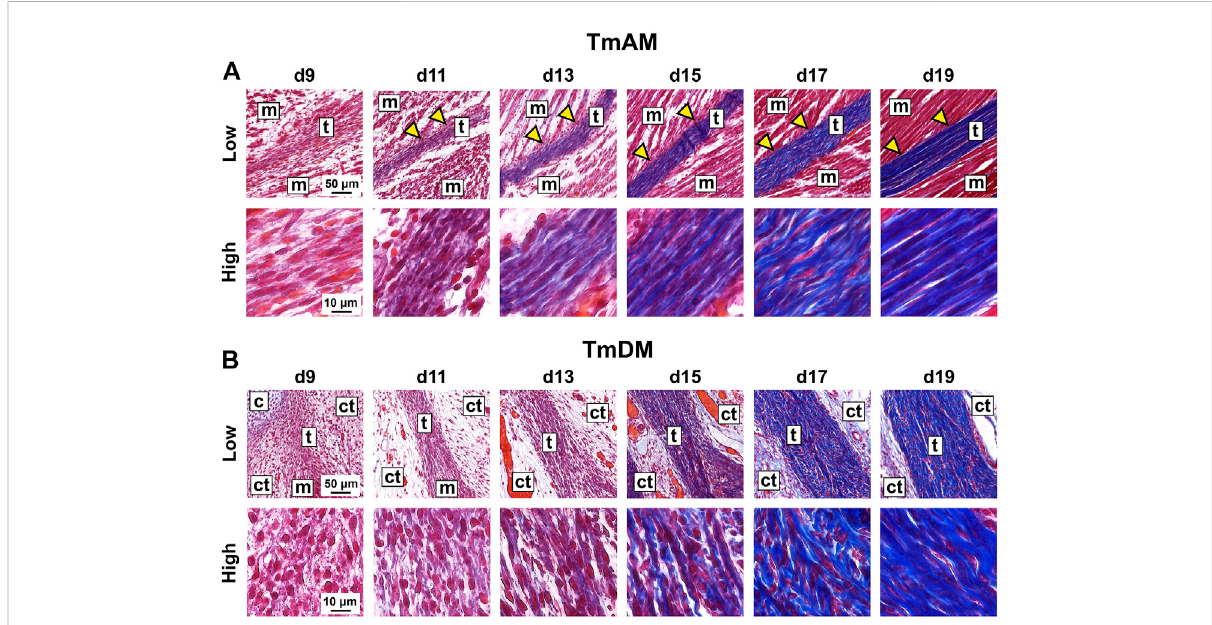
FIGURE 2 Collagen content appeared to increase and become more organized in jaw-closing TmAM and jaw-opening TmDM between d9 and d19. (A) Lowandhighmagni fi cationbright fi eldimagesofMallory ’ strichromestainingofTmAMshowcollagencontent(blue)increasingandbecomingmore organized between d9and d19. Yellow arrows highlight muscles attachingalonglength of TmAM. (B) Lowand high magni fi cationbright fi eld images of Mallory ’ s trichrome staining of TmDM show collagen content (blue) increasing and becoming more organized between d9 and d19. Tendon (t), muscle (m), cartilage (c), loose connective tissue